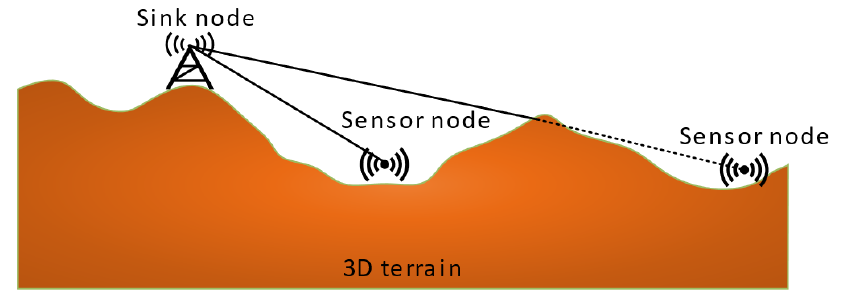
Figure 1. Line of Sight mode.